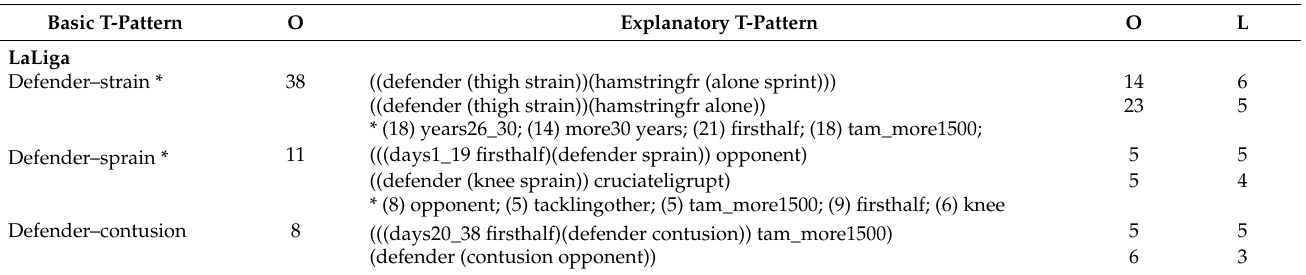
Table 5. T-Patterns according to league, position (defender, midfielder and forward) and the most frequent injury (strain, sprain, contusion and